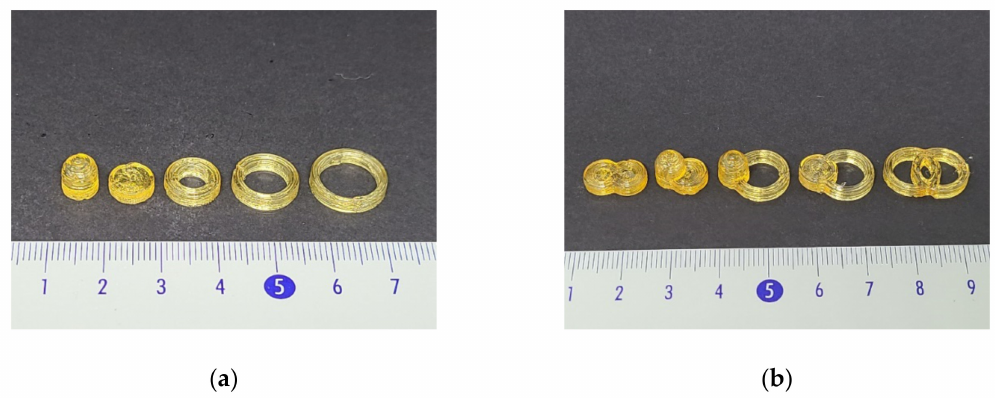
Figure 2. ( a ) Appearance of printed solid dosage forms of float, cylinder, D10 ring, D12 ring, and D14 ring from the left. ( b ) Appearance of printed combined solid dosage forms of CC, CF, RF, CR, and RR from the left.